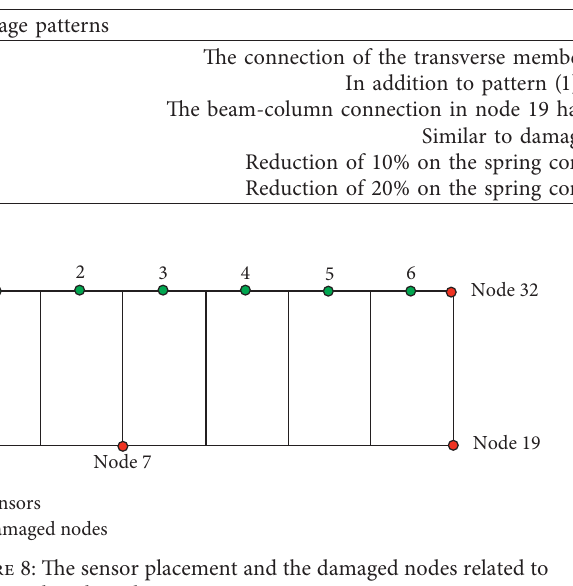
Figure 7: Scheme of the BHM benchmark structure [38]. Table 3: Damage patterns considered for the BHM benchmark structure [38].